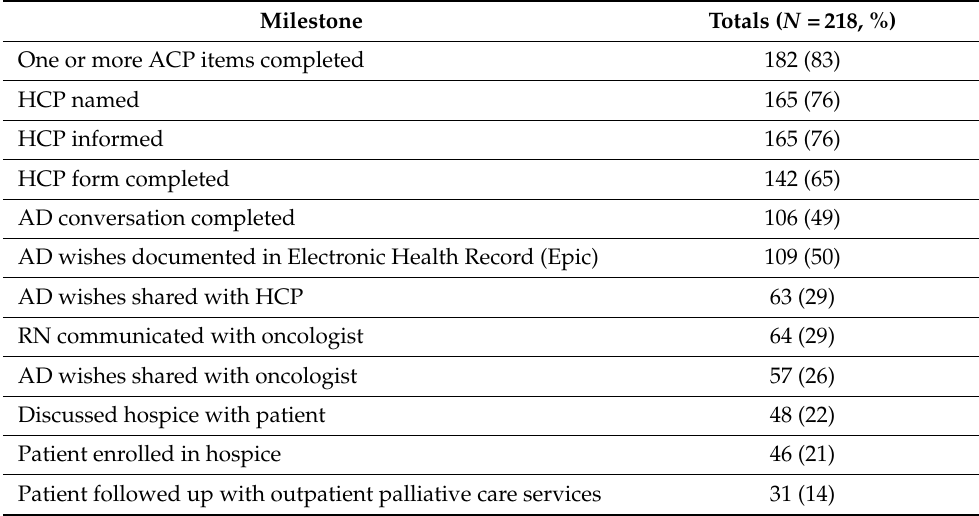
Table 3. Advance care planning (ACP) milestones completed among study